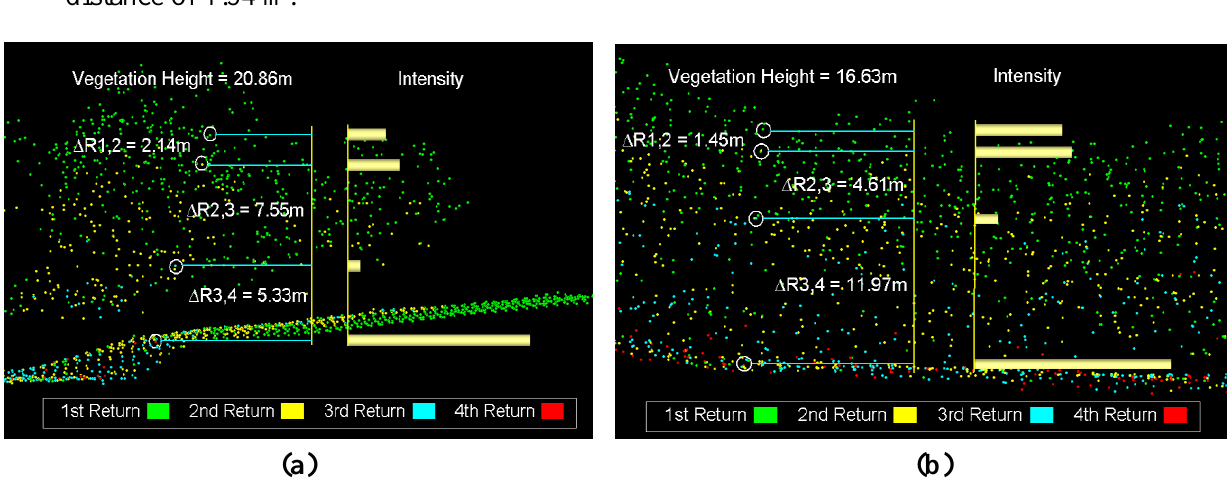
Figure 1. Examples of four-return records from vegetation; (a) ALTM 3100; minimum pulse return separation distance of 2.14 m; (b) ALTM Gemini: minimum pulse separation distance of 1.54